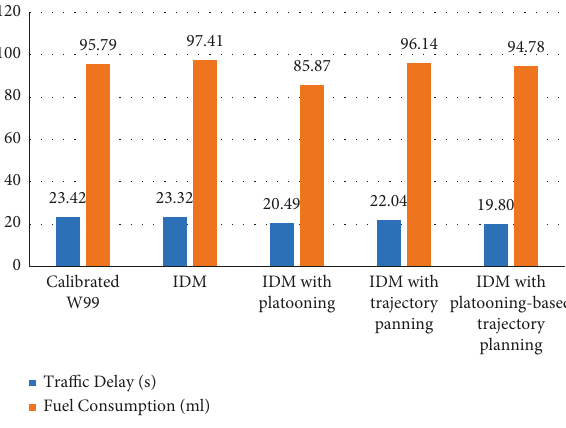
Figure 9: Traffic performances with different scenarios. Table 4: CAV performances compared to HDVs with calibrated